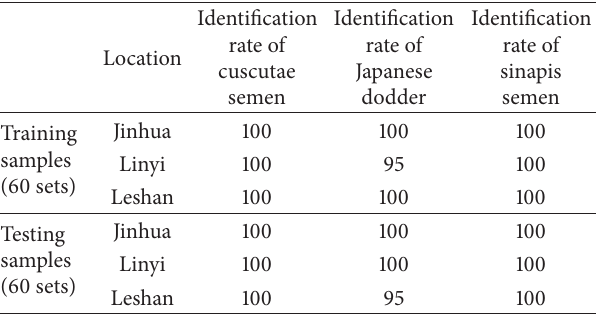
Table 1: Training and testing results by RBF neural